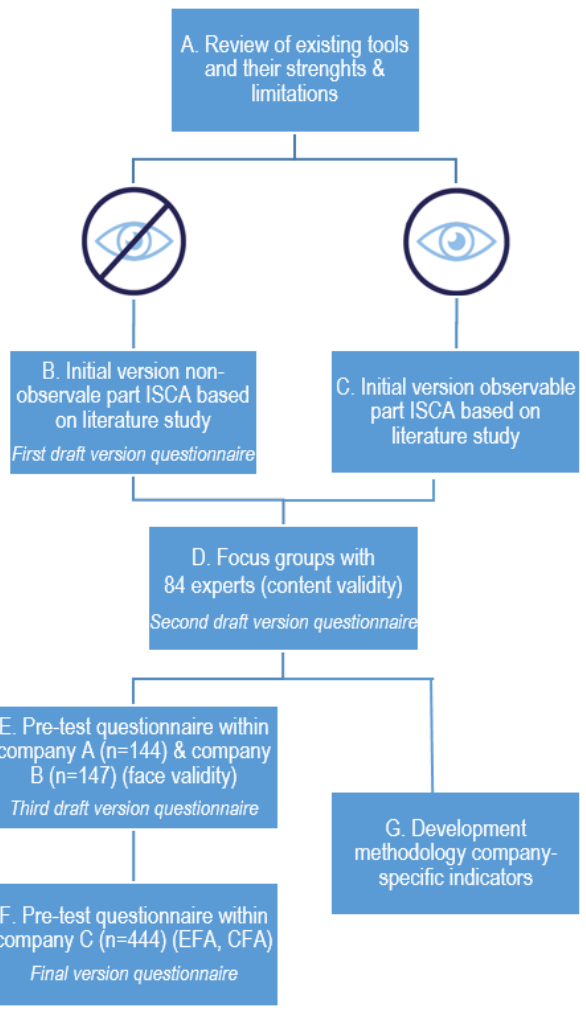
Figure 3. Development process of Integrated Safety Culture Assessment (ISCA).